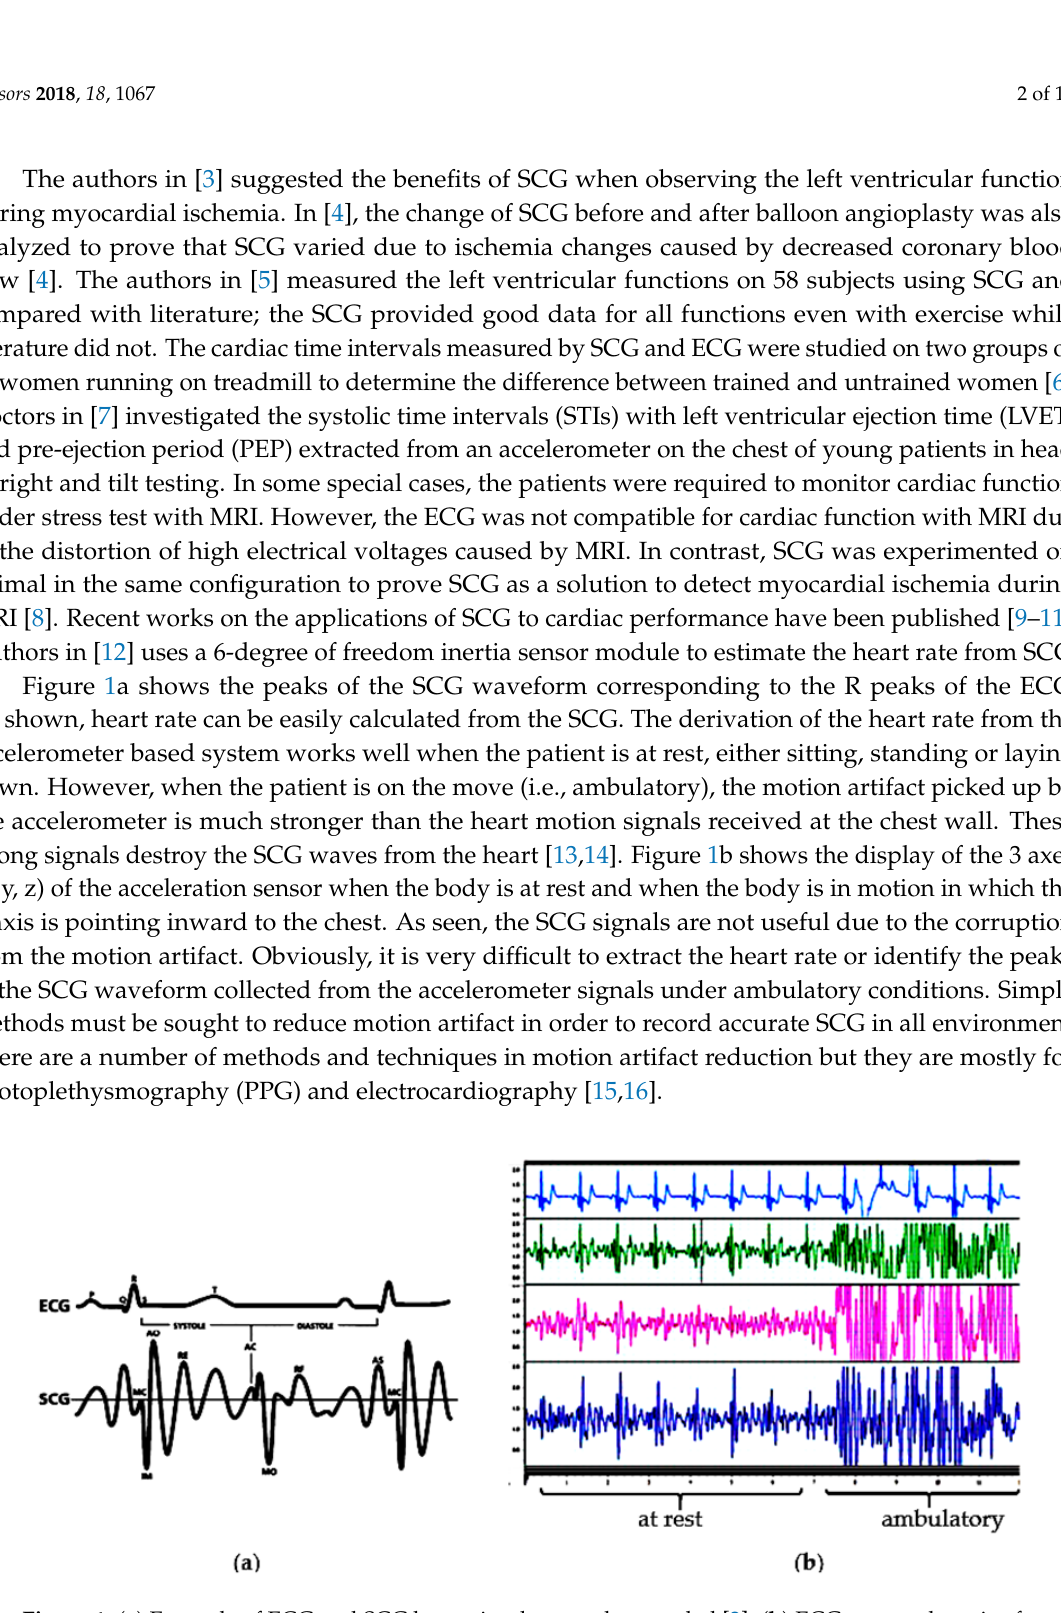
Figure 1. ( a ) Example of ECG and SCG beats simultaneously recorded [2]. ( b ) ECG, x, y, and z axis of the SCG during resting and walking from experimental